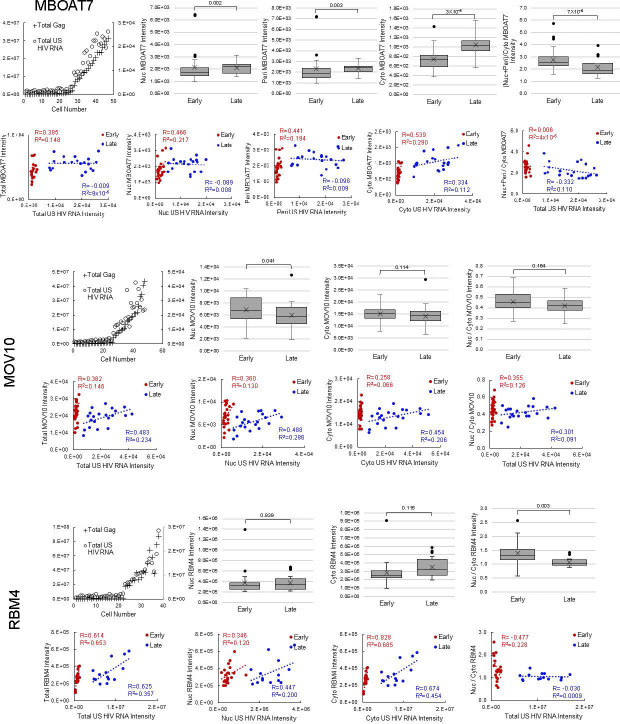
Host protein expression and cellular distribution.